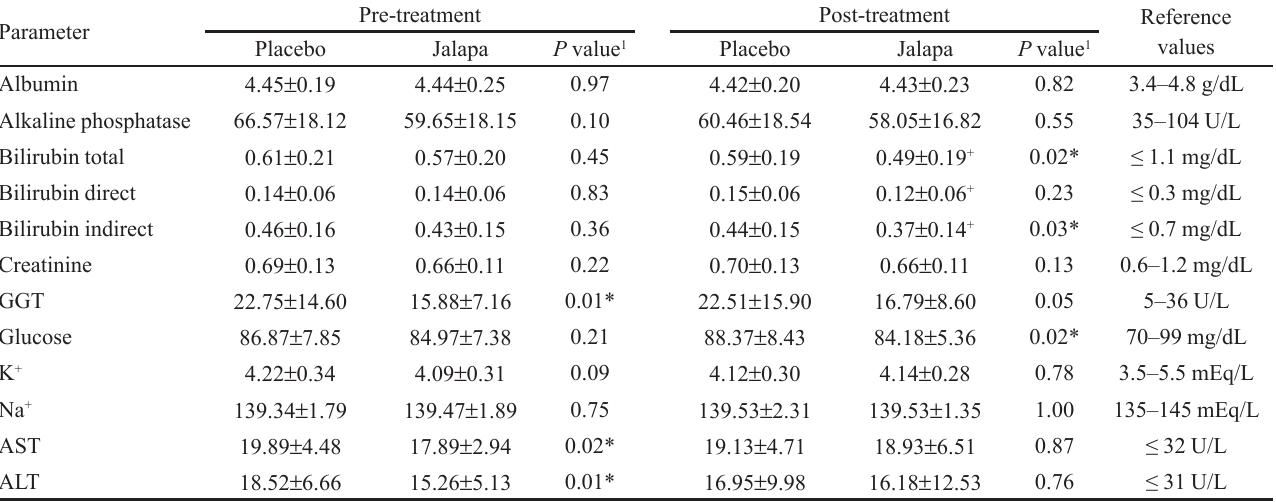
TABLE II – Metabolic and liver and kidney function laboratory test results of the placebo and jalapa groups in the pre-treatment and post-treatment, expressed as mean ± standard deviation